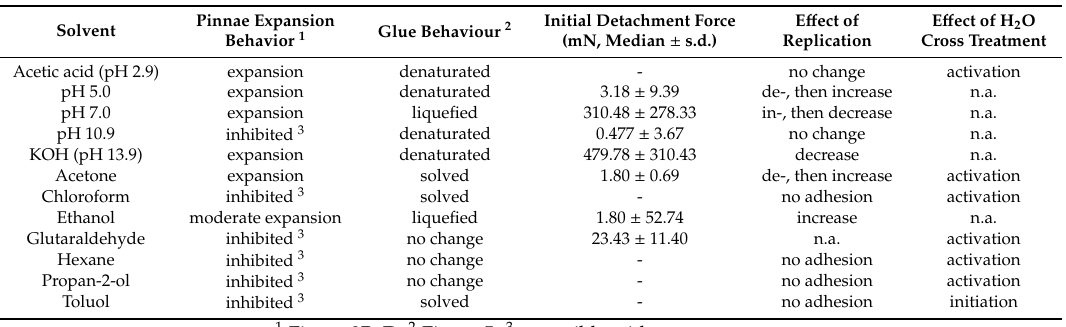
Table 2. Responses of the egg adhesive system to the exposure to di ff erent solvents. Pinnae expansion as shown in Figure 3. Glue behavior: denaturated, aggregation of the glue; liquefied, glue mobilization